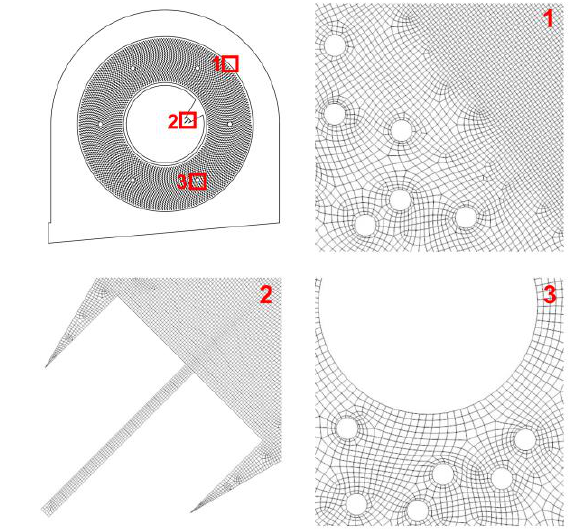
Fig. 4. Details of computational mesh